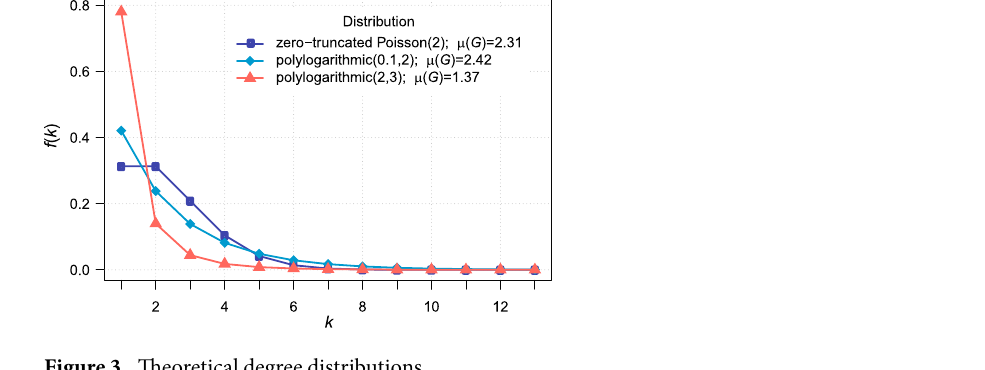
Figure 3. Theoretical degree